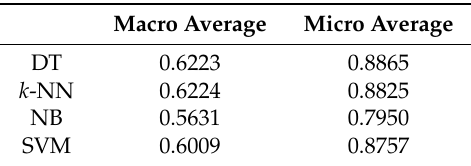
Table 4. Macro and micro F-measures for test